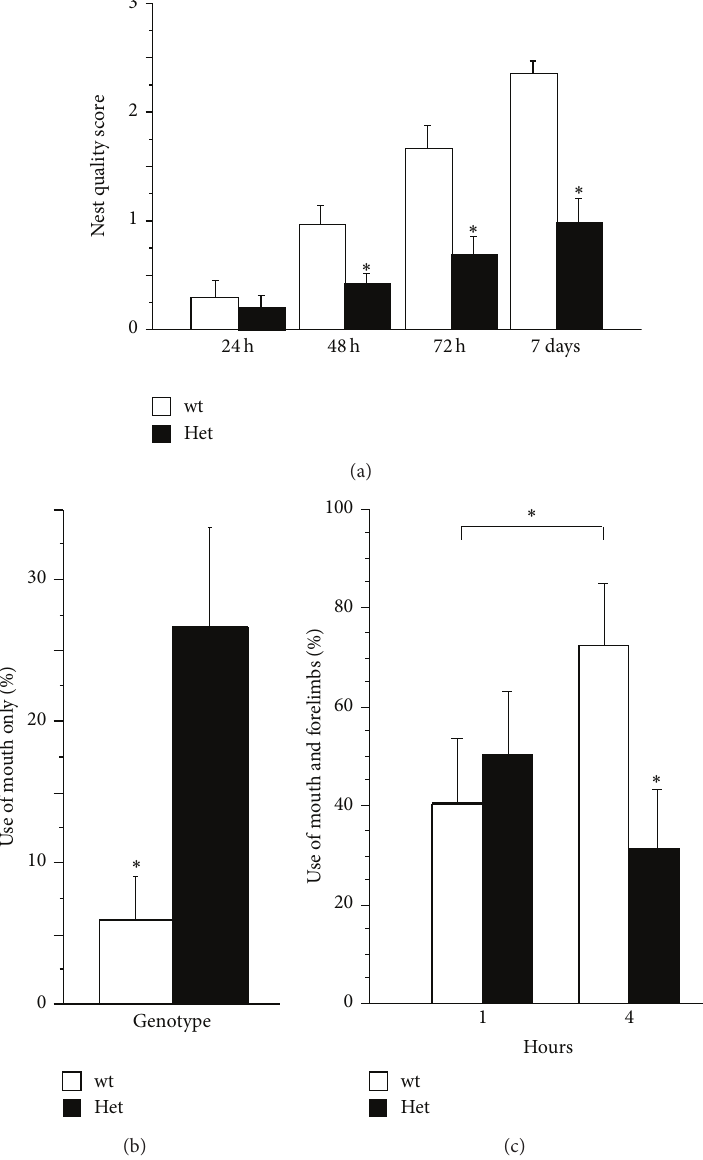
Figure 4: Nest building abilities in RTT female mice . (a) MeCP2-308 female mice (Het, 𝑁 = 13 ) built nests of significantly poorer quality compared to wild-typecontrols (wt, 𝑁 = 15 ). The quality of the nest was evaluated at 2h, 48 h, 72 h, and 7 days after the introduction of nesting material into the cage (scores: 0 = bad quality; 4 = high quality). (b) The analysis of spontaneous behaviour in the home-cages revealed that Het mice more frequently interacted with the material with their mouth only, a condition which was rarely observed in wt controls. (c) The simultaneous and coordinated use of the mouth and the forepaws needed to build a high quality nest was deficient in Het mice compared to wt littermates. Data are expressed as mean ± SEM. ∗ 𝑃 < 0.05